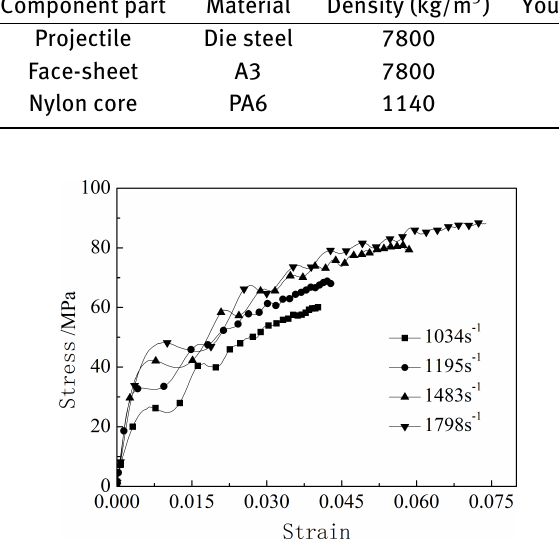
Figure 2: Stress-Strain curve of nylon in different strain rate